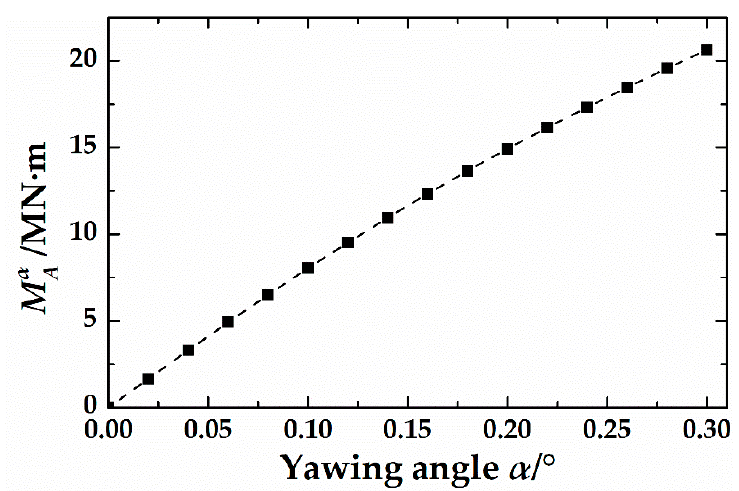
Figure 21. The relationship between the yawing angle and M A α .